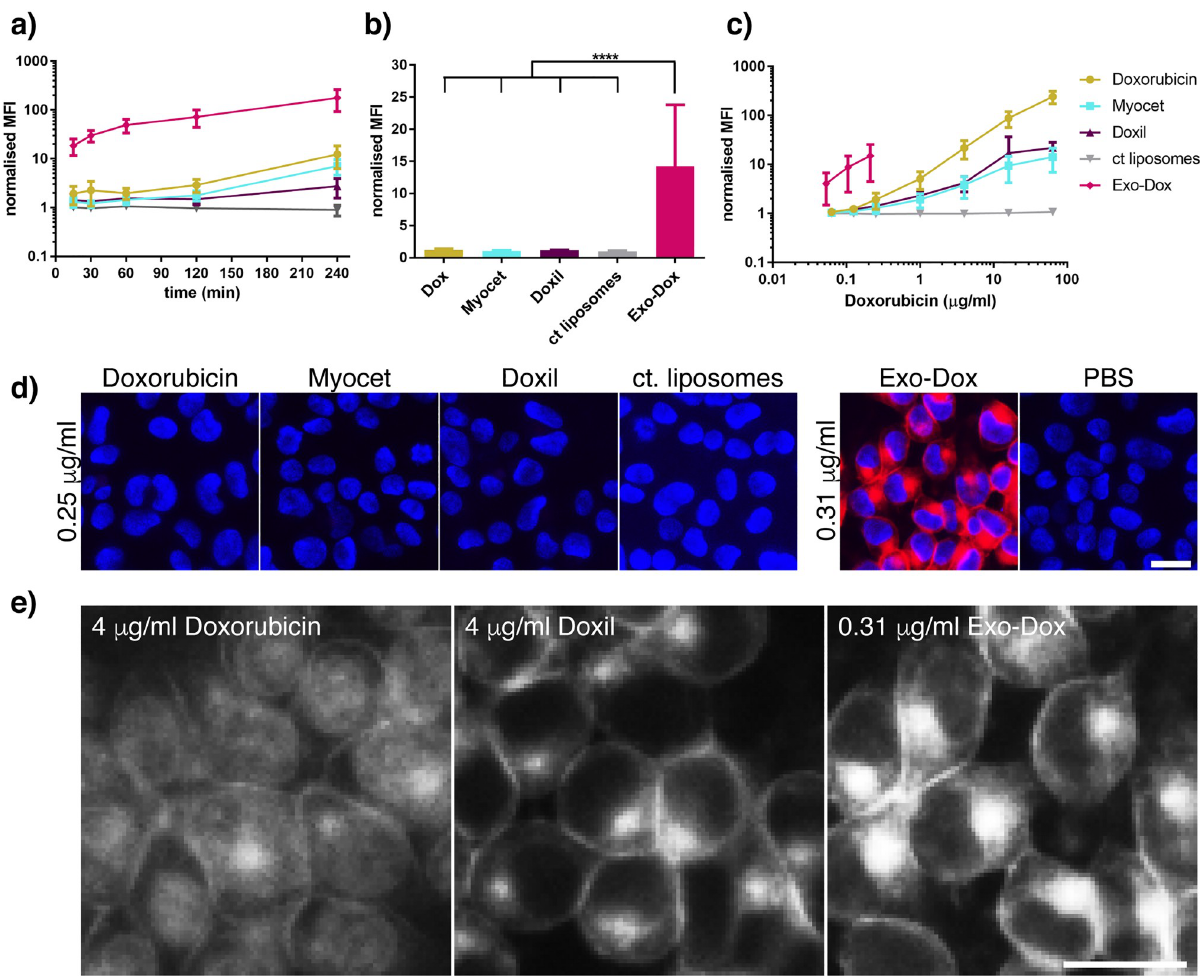
Fig 2. Rapid internalisation of exosomal doxorubicin. (a) HEK293 cells were incubated with 0.25 μ g/ml Dox, Exo-Dox, liposomal formulations of Dox or PBS as control in duplicate for increasing amounts of time. Doxorubicin uptake was analysed by flow cytometry as described in Fig 1. (b) uptake was performed as described in (a) for 15 min. (c) HEK293 cells were incubated with increasing amounts of Dox, Exo-Dox, liposomal formulations of Dox or PBS for 15 min and uptake was assessed by flow cytometry analysis. (a,b,c) MFI values were normalised to MFI values obtained by incubation in PBS. All experiments were performed n = 3 times, data is presented as mean +/-SD, ���� p < 0.0001. (d) HEK293 cells were incubated with Dox, Exo- Dox, liposomal formulations of Dox (red) at concentrations indicated for 15 min followed by staining of the nuclei with Hoechst (blue). Uptake was analysed by epifluorescence microscopy; (e) experiment was performed as in (d), images for Dox concentrations that result in comparable recipient cell fluorescence are shown. (d,e) representative images from one (out of three) independent experiments are shown. Scale bar in microscopic images: 10 μ